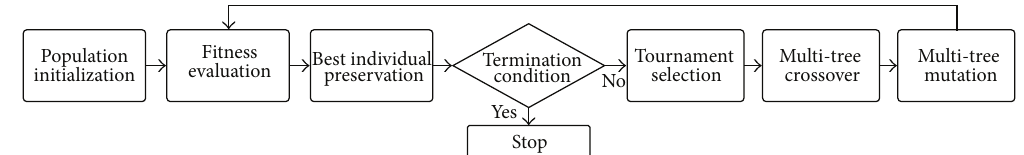
Figure 6: The proposed GP framework.